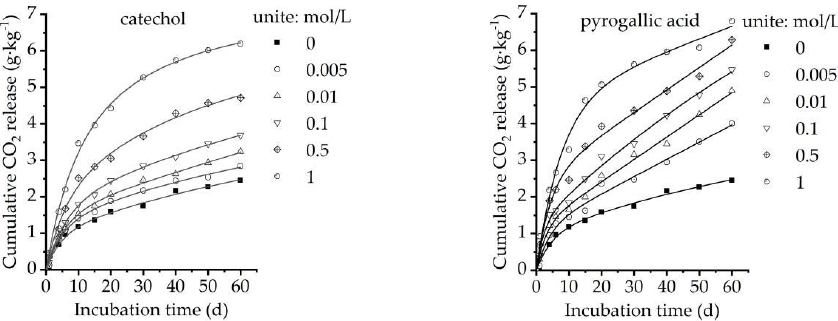
Figure 1. Effect of organic acids on soil organic carbon mineralization.